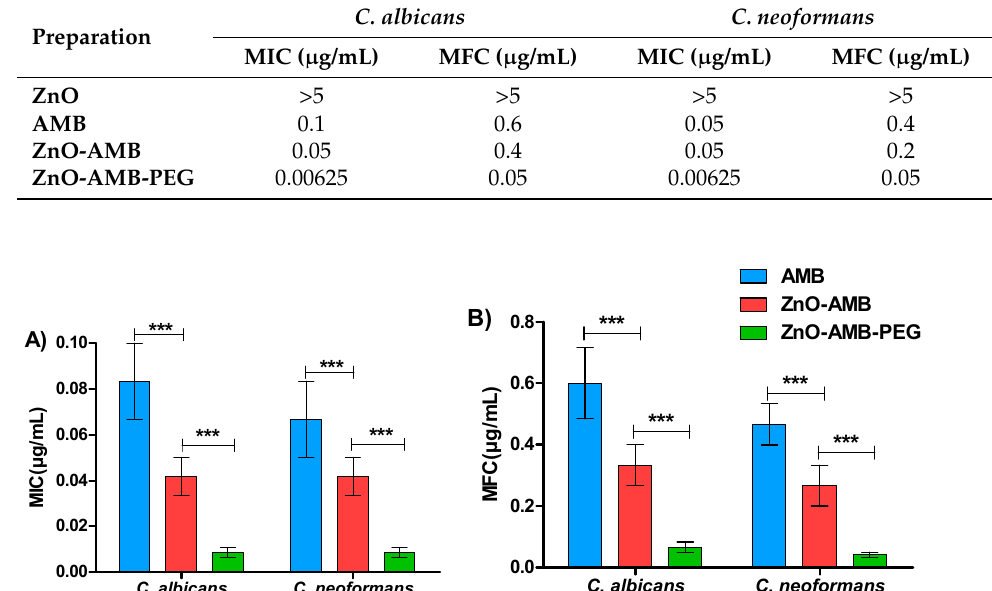
Table 2. Antifungal activity of AMB nanoparticles. Preparation